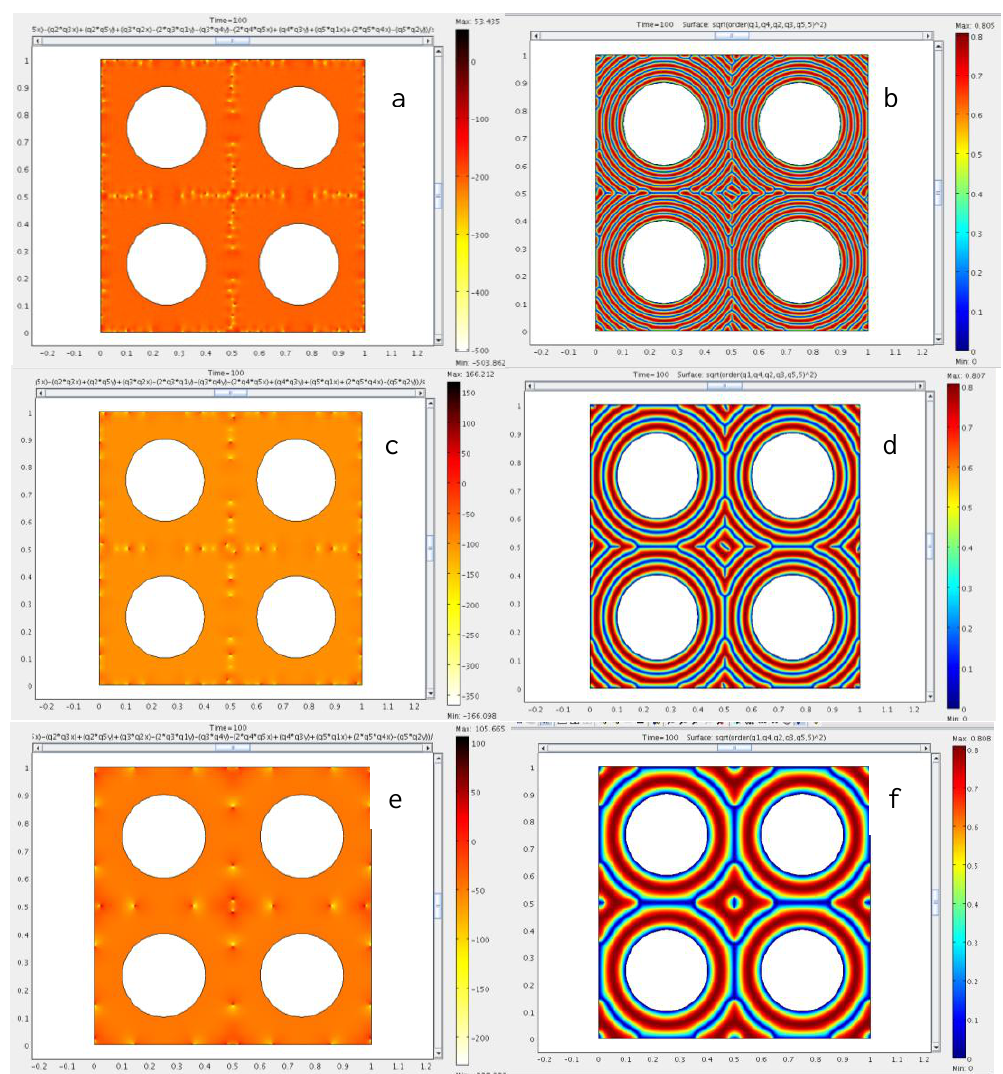
Figure 6. Simulation results for chiral nematic self assembly at t = 100, for length scales ξ/h = 0.0025, υ= 1 and U = 6, for varying (ξ/p 0 (left) and out-of-plane component |n and (b); 0.025 (c) and (d); 0.025 (e) and